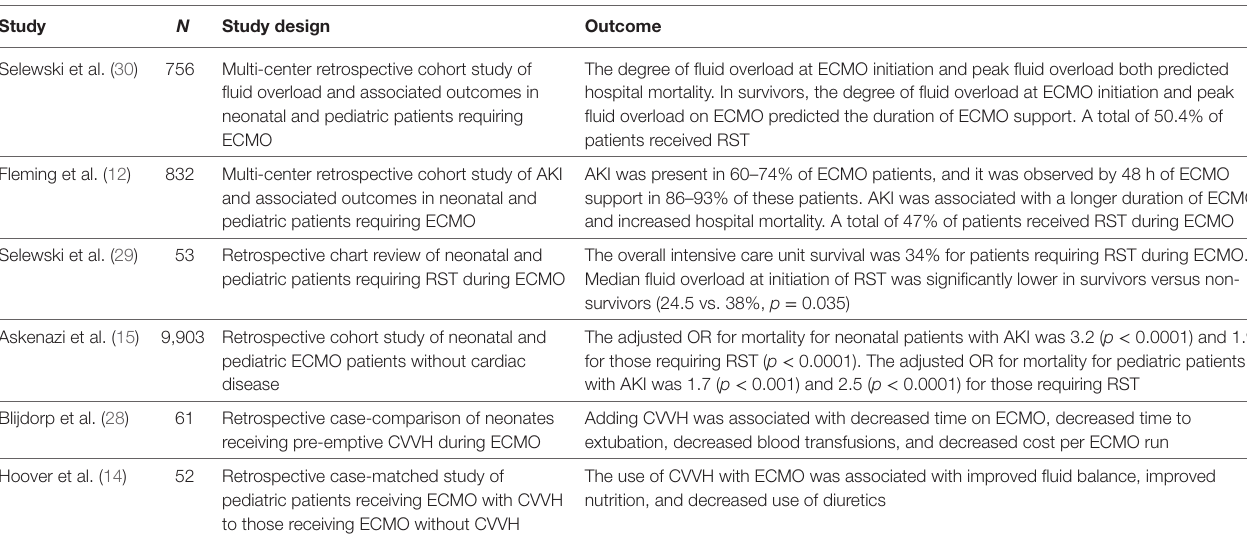
TAbLe 1 | Pediatric studies of ECMO and